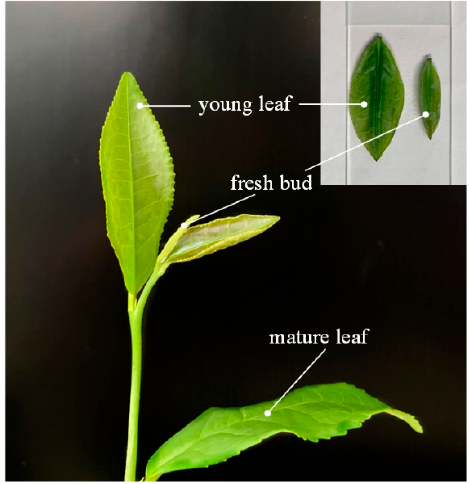
Figure 1. Fresh bud and young leaf on the canopy of tea tree.